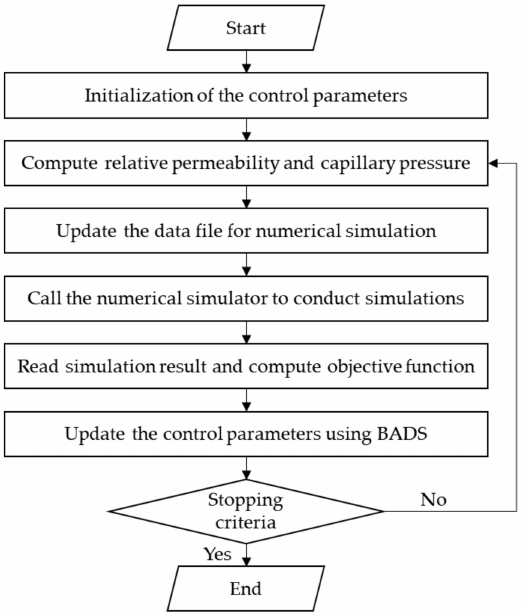
Figure 4. Illustration of the assisted history matching